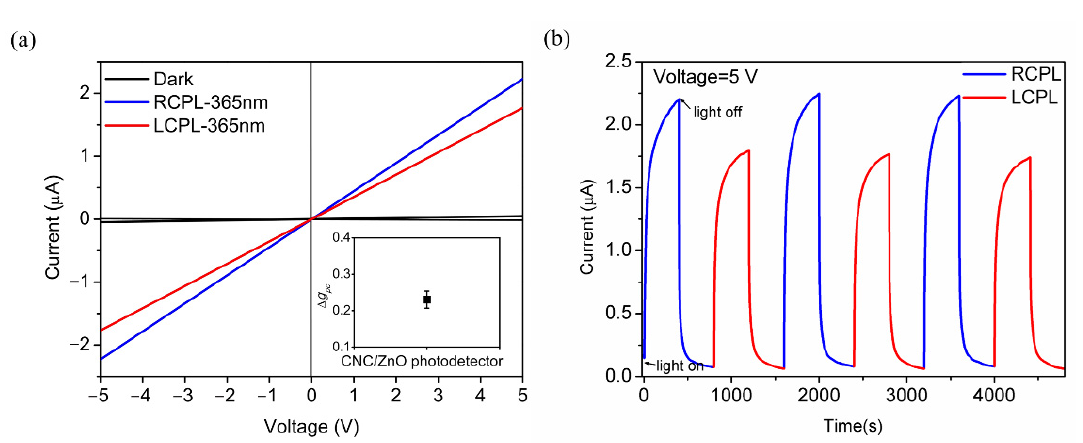
Figure 7. ( a ) I–V characteristics under dark, LCPL-365 nm and RCPL-365 nm illumination of CNC/ZnO photodetector. Insert: ∆ g pc of CNC/ZnO photodetector. Error bar represents standard error in measurement. ( b ) I-t characteristics with recyclable response under the repetition of LCPL and RCPL switching for CNC/ZnO photodetector.